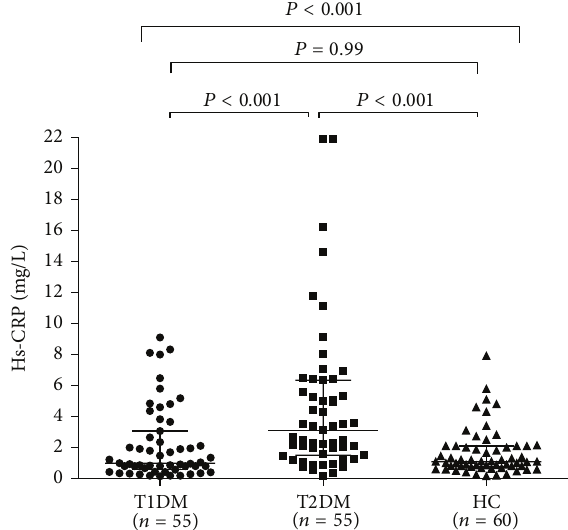
Figure 4: Serum hs-CRP levels in different groups. Data are pre- sented as single data points. Serum hs-CRP levels were significantly higher in T2DM than in the other groups. No difference was found between T1DM patients and